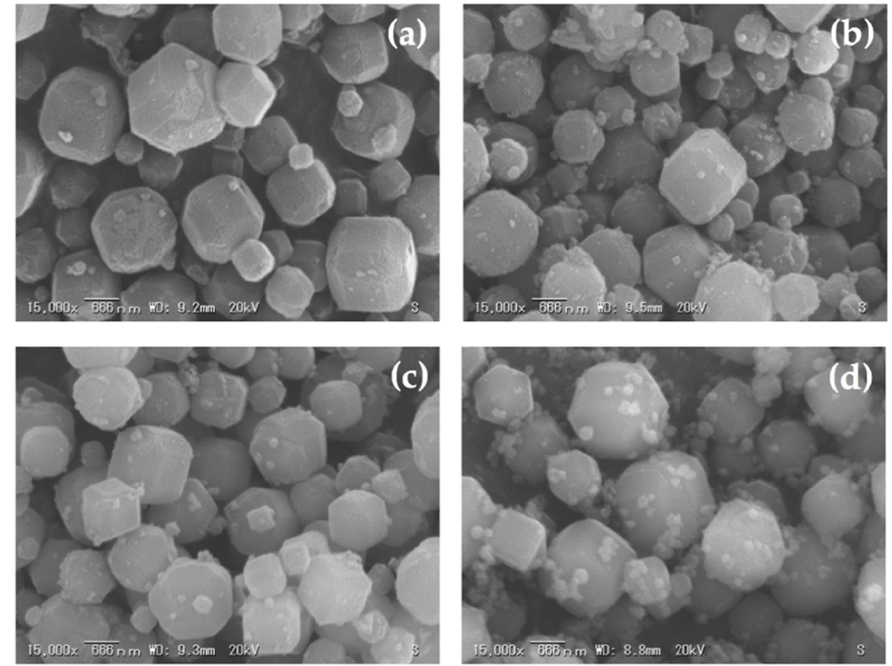
Figure 12. Morphologies of synthesized zeolite A with a curing time of 12.0 h and related phases achieved using different corn stover ash:NaOH ratios: ( a ) corn stover ash:NaOH = 1:0.5, ( b ) corn stover ash:NaOH = 1:1.0, ( c ) corn stover ash:NaOH = 1:1.5, ( d ) corn stover ash:NaOH = 1:2.0.